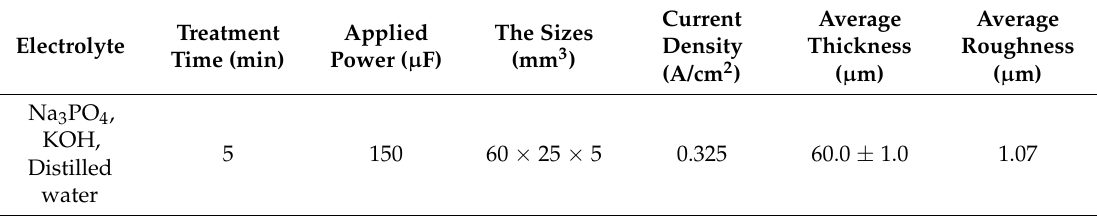
Table 1. The MAO coating parameters and the surface analysis results of the coatings such as thickness.